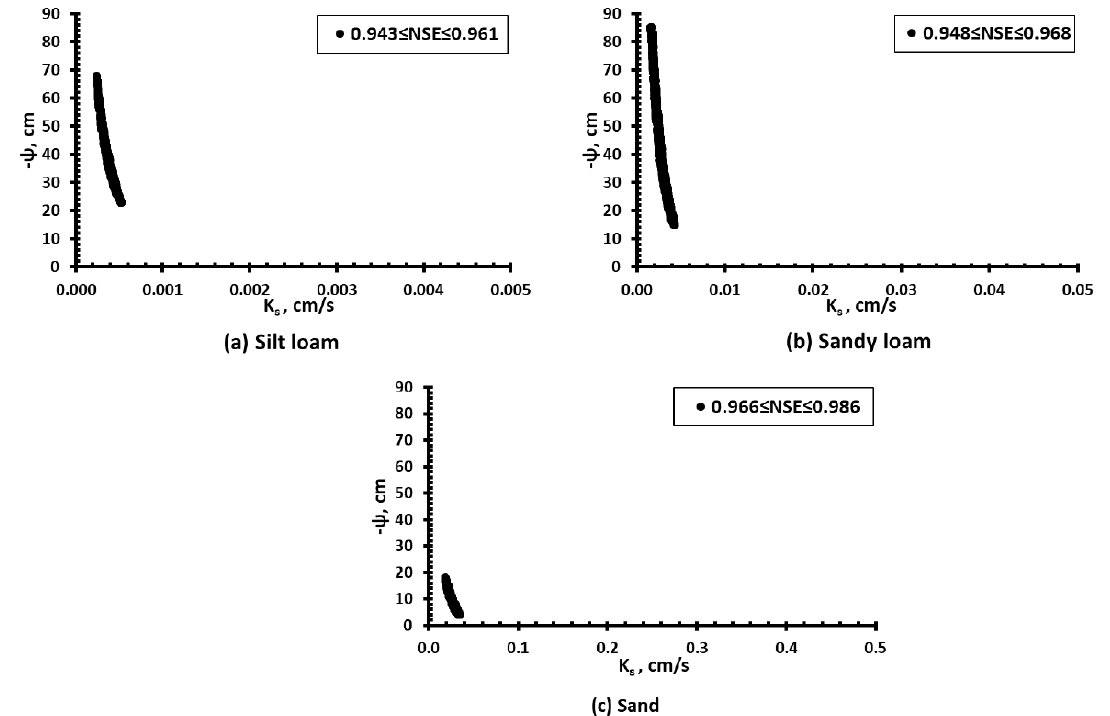
Figure 6. The successful sets of parameters K s versus – Ψ (delineated by NSE ≥ the threshold value) determined from simulation using ∆ t sj determined by Equation (6) and the measured time intervals ∆ t j : ( a ) silt loam, ( b ) sandy loam, and ( c ) sand. Note: The limits for K s (or x-axis) are different for the three soils.